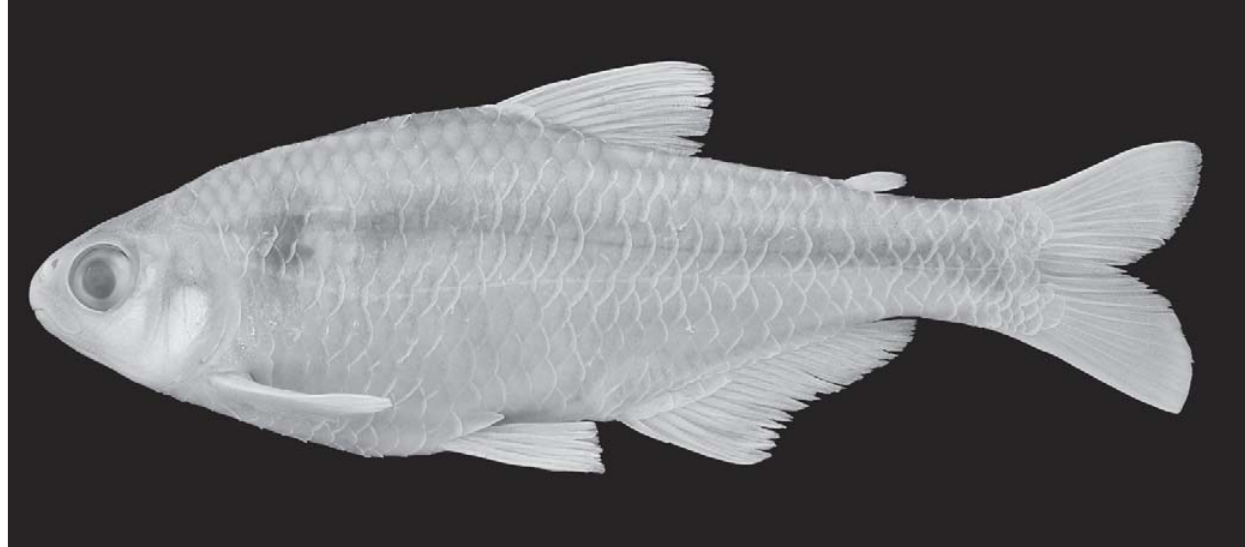
Fig. 3 . Bryconamericus ecai , holotype, MCP 19608 (60,6 mm SL, male), lateral view. Scales cycloid. Caudal fin not scaled. Single row of 4-9 (6) scales covering base of anteriormost anal-fin rays. La- teral line complete, 37-40 (38) perforated scales; 5-6 (5) scales in transverse series from dorsal-fin origin to lateral line; 4-5 (5) scales between lateral line and anal-fin origin. Predorsal scales 13-15 (15), sometimes in irregular series. Scales around caudal peduncle 14. Vertebrae: precaudal 16-17, caudal 20- 21. Supraneurals 5-6 (in seven c&s specimens). Color in alcohol . Ground color tan. Dorsal portions of head and body region above midlateral stripe more pigmented. Dark midlateral stripe present, more conspicuous posterior to ver- tical through dorsal-fin origin, not reaching upper and lower